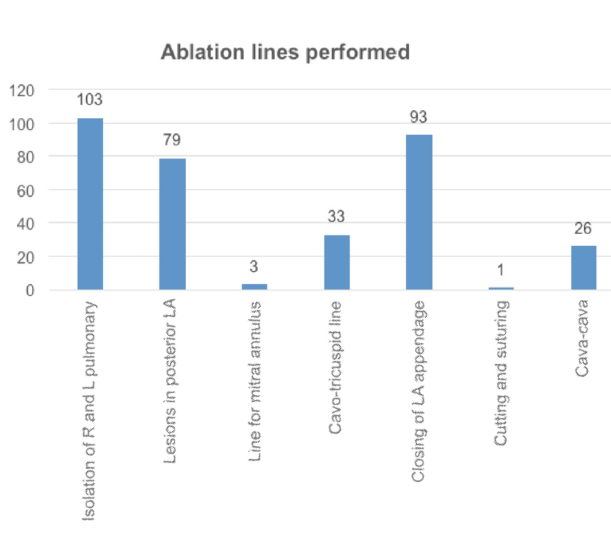
Fig. 4 - Ablation lines performed. Results expressed in